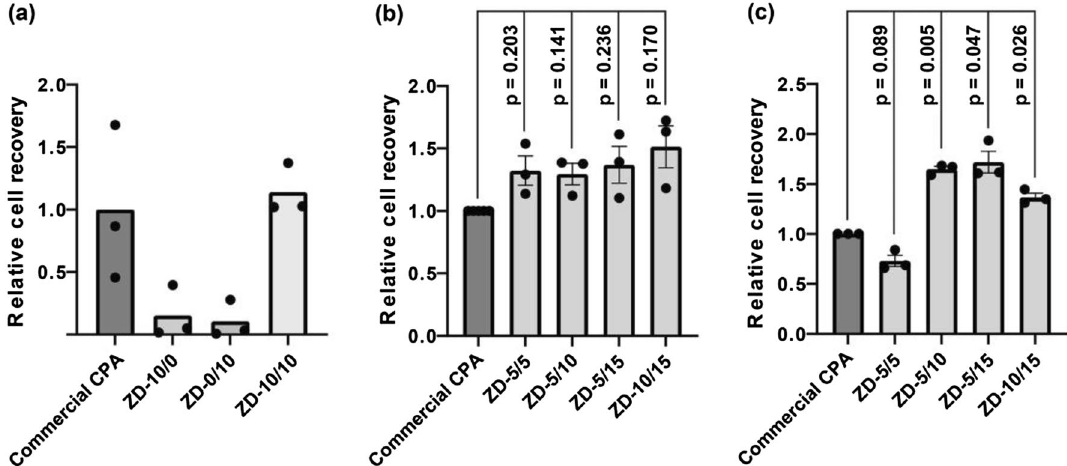
Figure 2. Relative cell recoveries of cryopreserved mouse melanoma cell spheroids post-thaw using different mixtures of zwitterion and DMSO. ( a ) Initial tests on non-optimized mixtures with cell recoveries measured immediately post-thaw ( n = 1, experimental triplicates). ( b ) Optimization of mixture concentrations with cell recoveries measured immediately post-thaw ( n = 3, biological triplicates). ( c ) Optimization of mixture concentrations with cell recoveries measured after 24 h of incubation post-thaw ( n = 3, biological triplicates). The bars show standard errors. The commercial CPA employed is CultureSure® freezing medium (Fujifilm Wako Pure Chemical